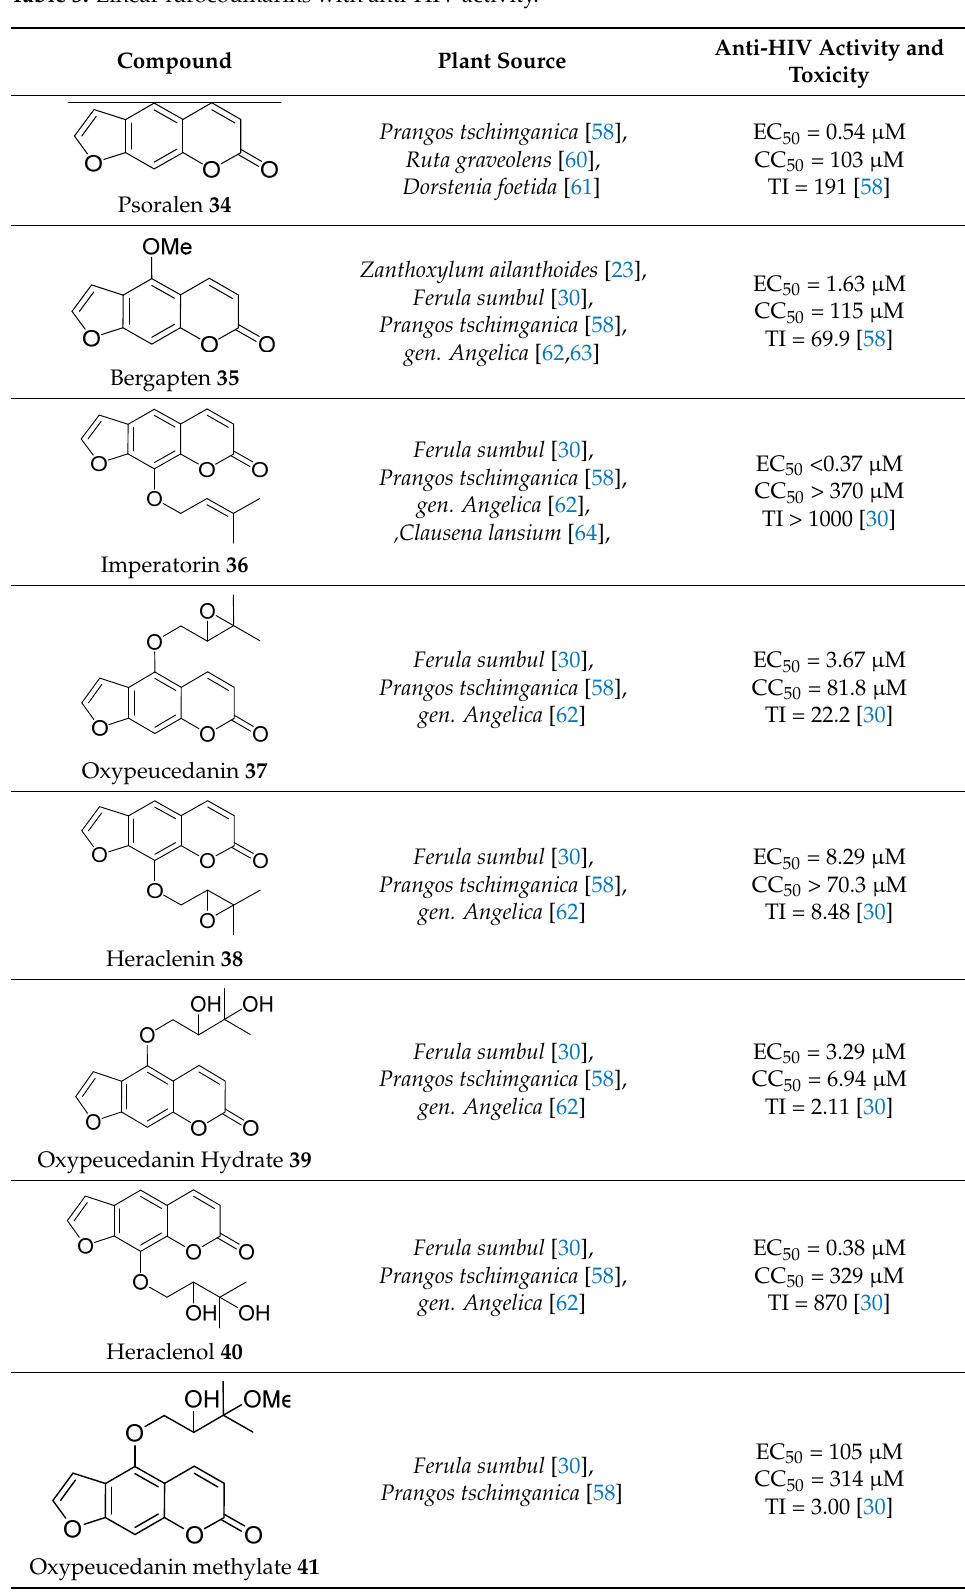
Table 3. Linear furocoumarins with anti-HIV activity.